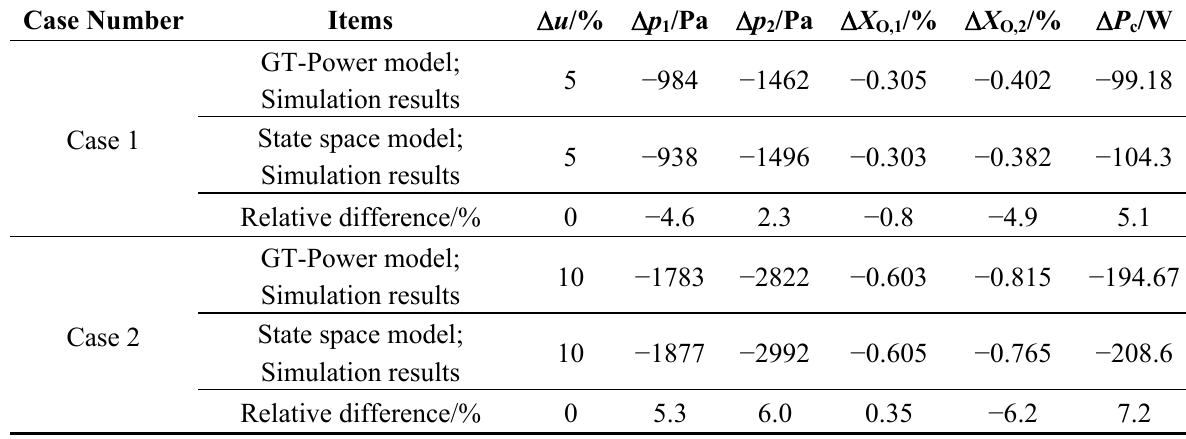
Table 1. Comparison